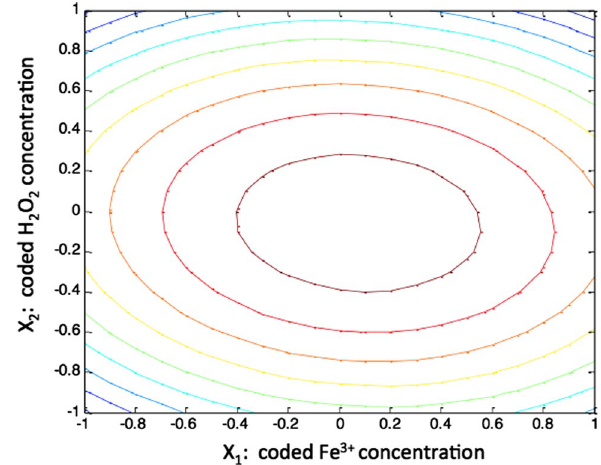
Fig. 4 Contour plot of dye removal showing interaction of Fe 3+ dos- age and H 2 O 2